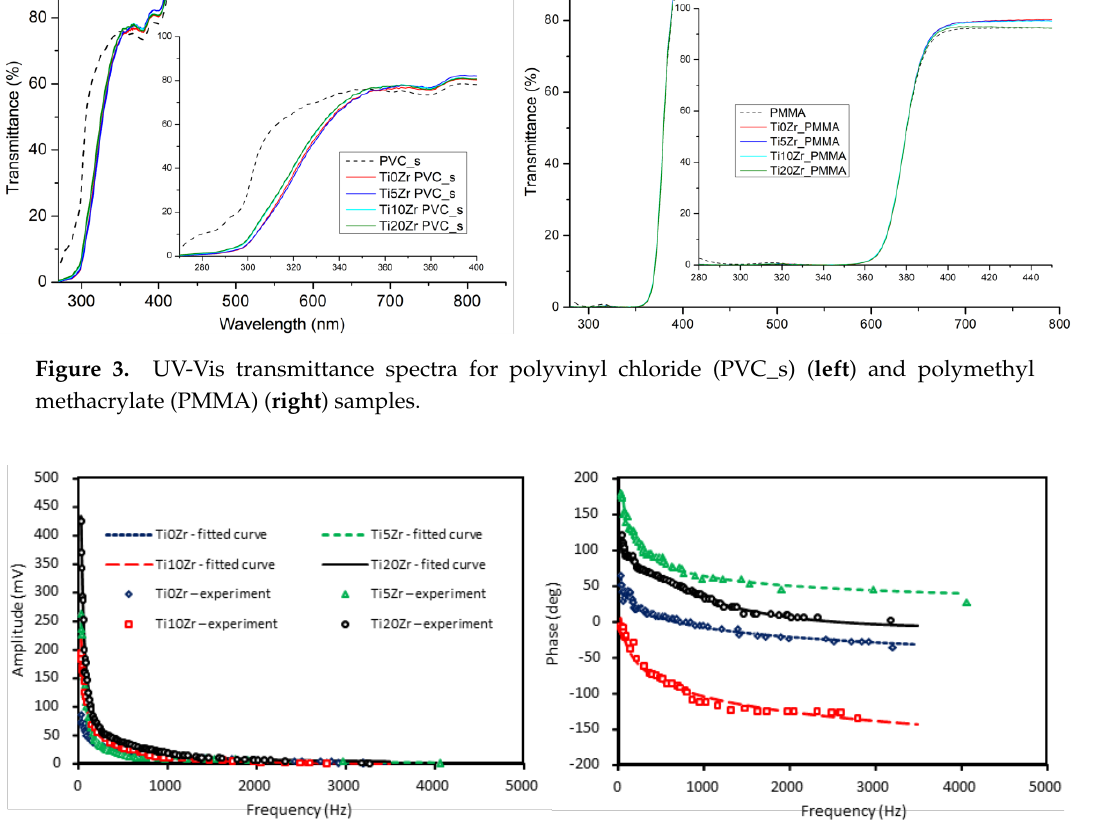
Table 2. Band gap and grain size values.